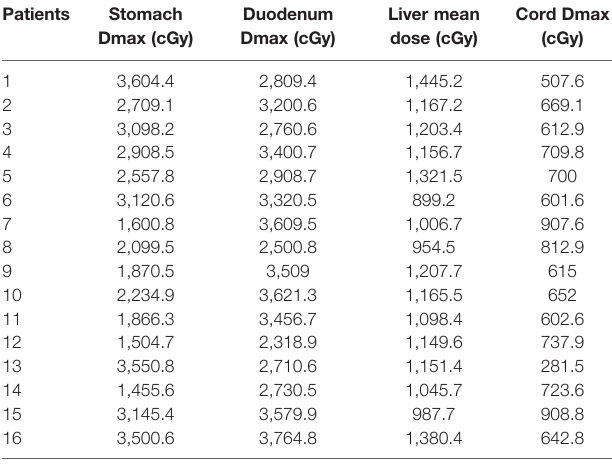
TABLE 2 | The actual dosimetry parameter of the OARs for the 16 patients. Patients Stomach Dmax